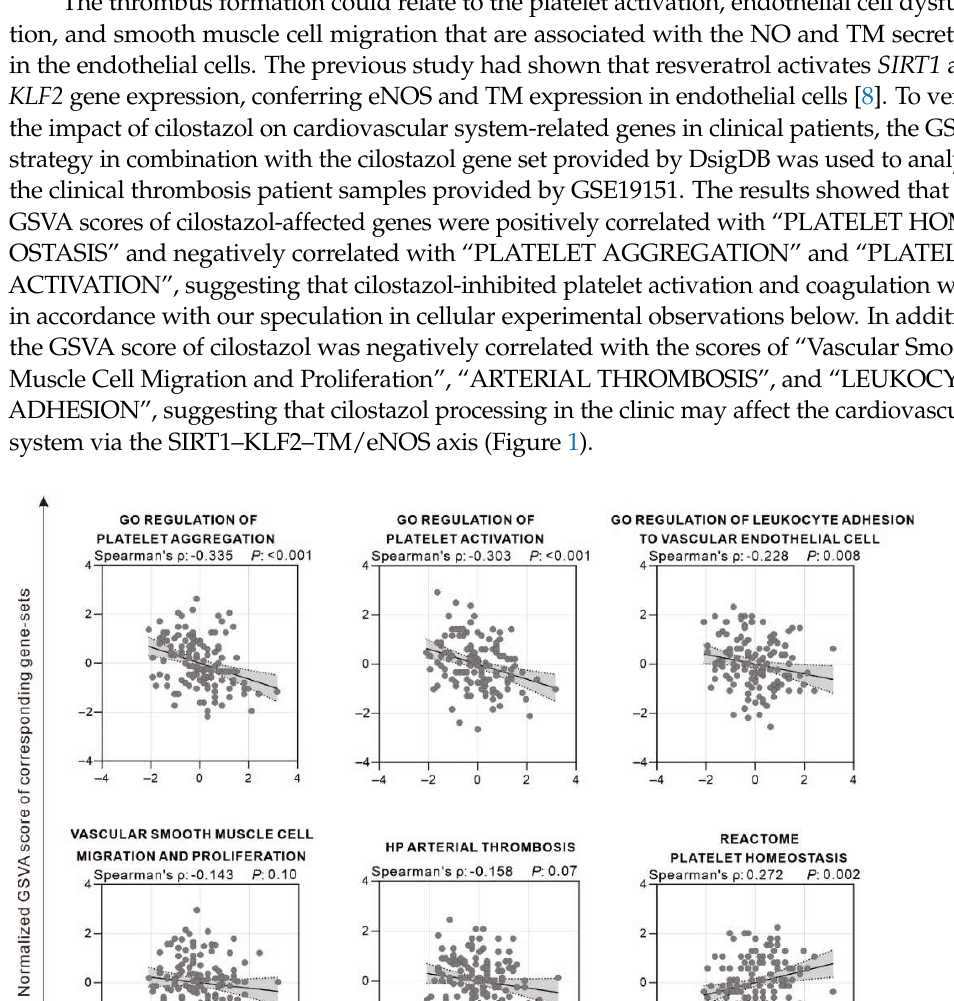
Figure 2. Cilostazol upregulates the expression of Krüppel-like factor 2 (KLF2). The HUVECs were incubated with 0, 30, and 100 μM cilostazol for 24 h. The mRNA expression of KLF2 and silent information regulator transcript-1 (SIRT1) in endothelial cells was assessed using ( A ) PCR and ( B ) quantitative real-time PCR, respectively. Additionally, protein expression was verified using ( C , D ) Western blot. Data are expressed as mean ± SEM. * p < 0.05, ** p < 0.01 and *** p < 0.001 vs. control. 2.3. Cilostazol Stimulates eNOS and TM Expression, and, Subsequently, Their Bioavailability Activated KLF2 plays a critical role in stimulating eNOS and TM activity as well as subsequent NO production when the endothelium is exposed to shear stress [21]. To ex- plore eNOS and TM expression after cilostazol treatment, the HUVECs were treated with 0, 30, and 100 μM cilostazol for 24 h. RT-PCR and Western blot were used to evaluate the effect of cilostazol on eNOS and TM expression. According to the result, in RNA and